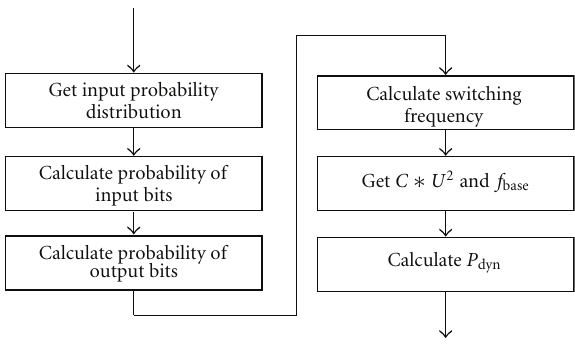
Figure 5: Optimized elementary cell for four-to-five-input LUT.